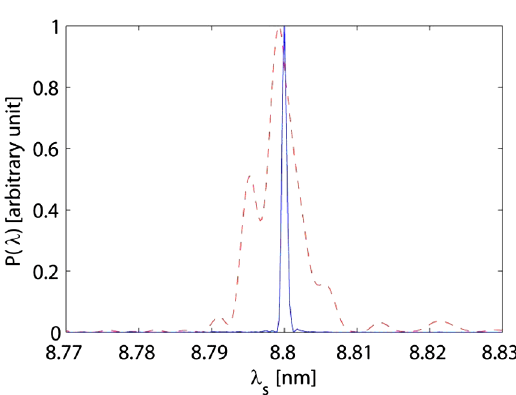
FIG. 6. Comparison of spectra at saturation for double-stage cascaded HGHG (red dashed line) and a single stage HGHG with three-dimensional phase space manipulation (blue solid